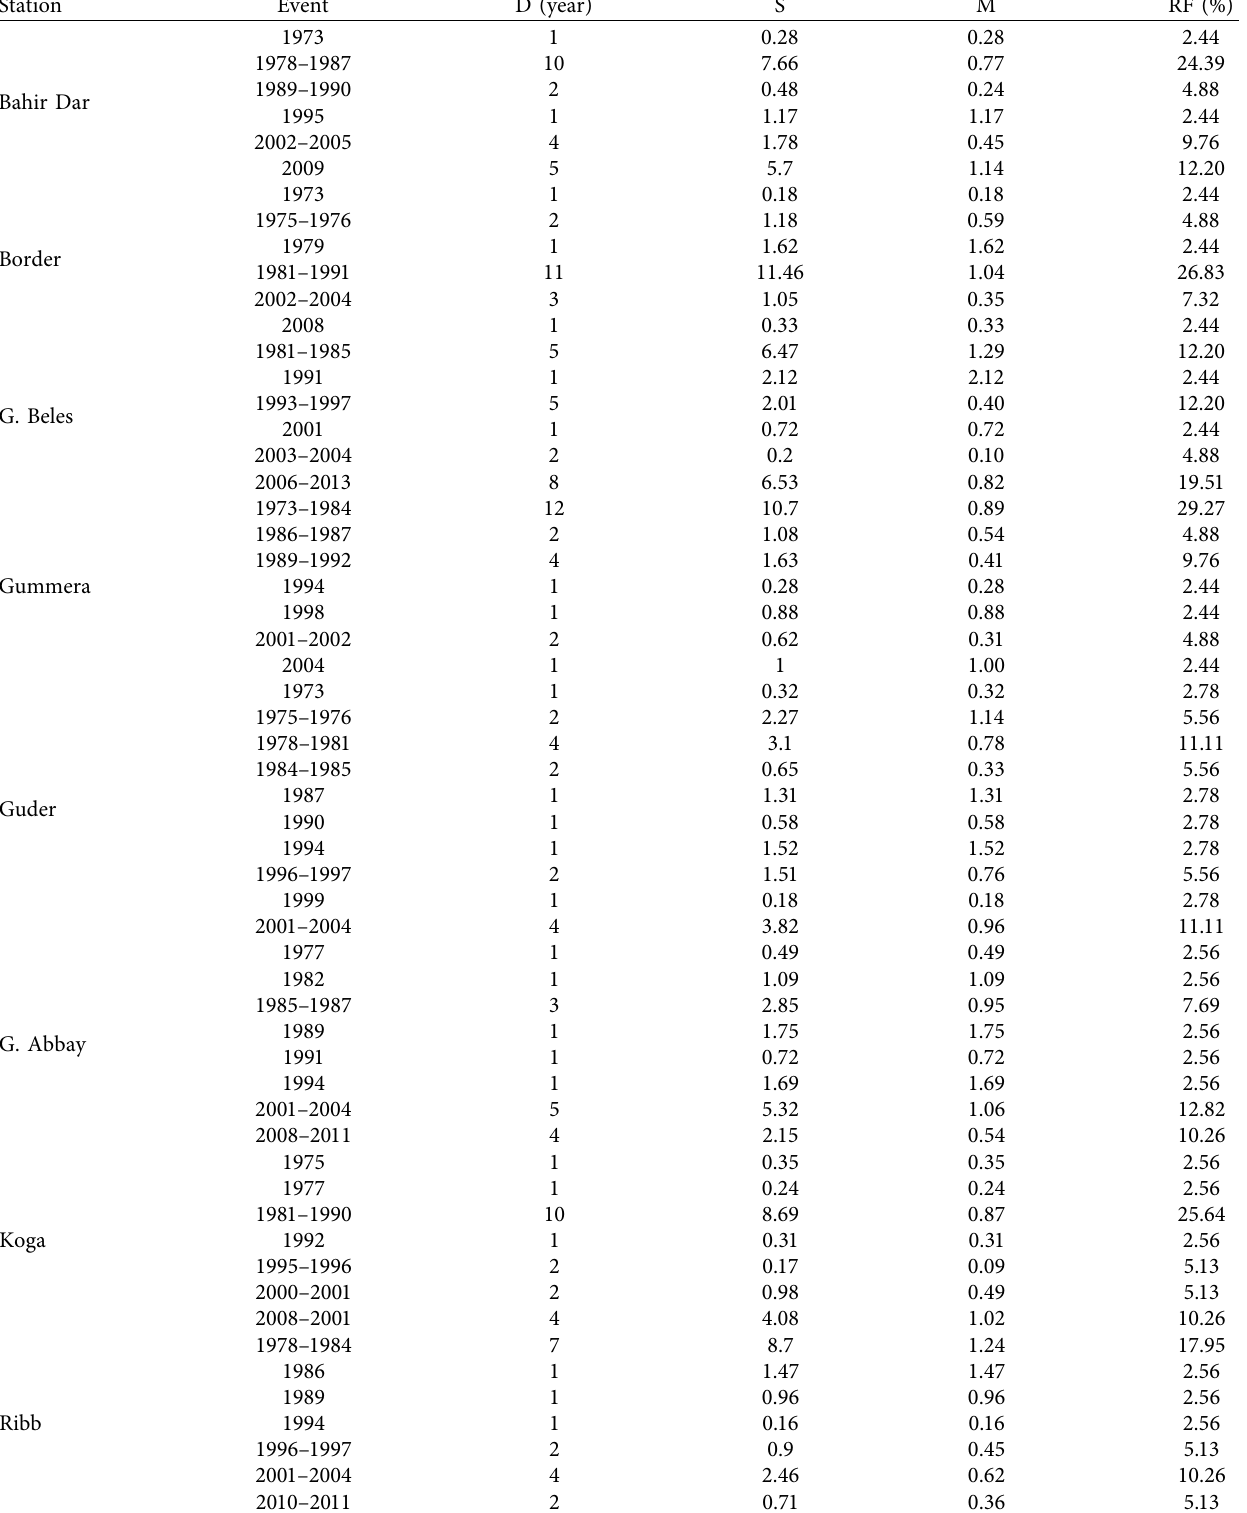
Table 8: Hydrological drought characterization in Ethiopian major river basins, Abbay river basin. Station Event D (year) S M